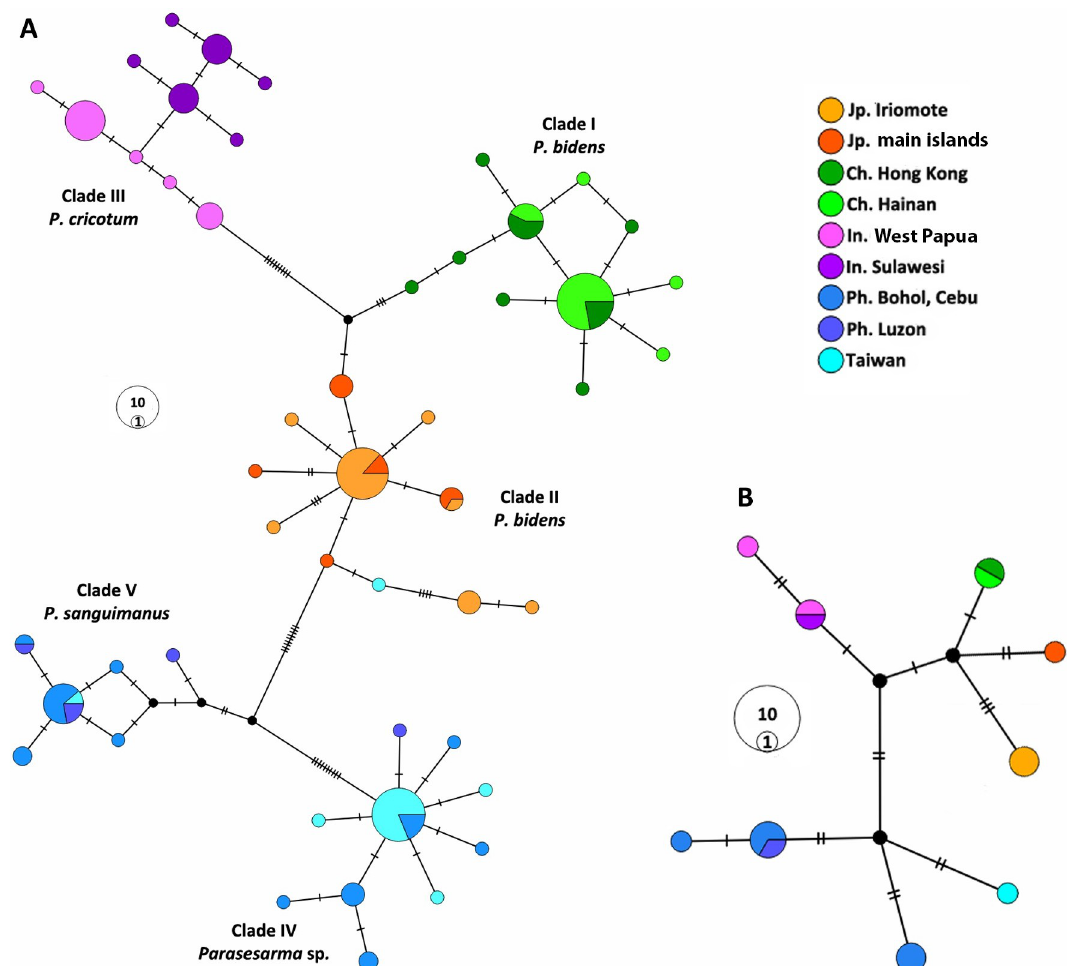
Fig 3. Haplotype networks. Maximum parsimony haplotype network, constructed with PopART. A. for the 3’ end of COX1 (618 bp). B. for 16S rRNA (529 bp). Hatch marks represent mutation steps. Ph, Philippines; Ch, China, Jp, Japan; In, Indonesia.